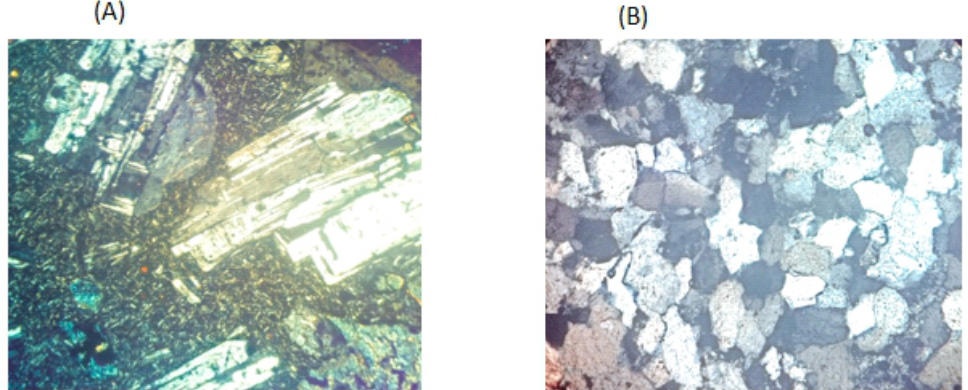
Fig. 5. Two samples of microscopic sections of the sediment samples in Taleghan Basin (A) plagioclase (anorthite), (B)